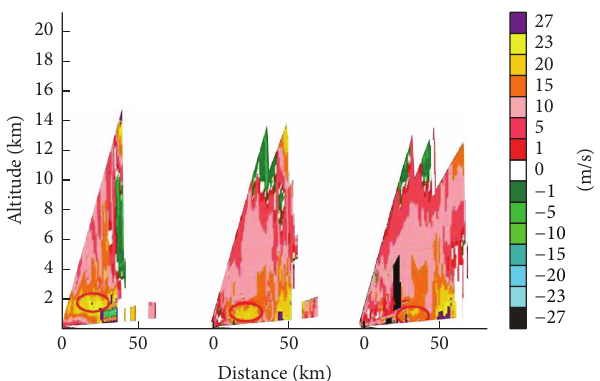
Figure 9: Vertical cross sections of radial wind speed as seen by Doppler radar at the WUHN station on July 27, 2007, at 8:14 p.m., azimuth at 342.00 ∘ (left), 8:26 p.m., azimuth at 345.00 ∘ (center), and 8:38 p.m., azimuth at 352.00 ∘ (right). The units for the radial wind speed are